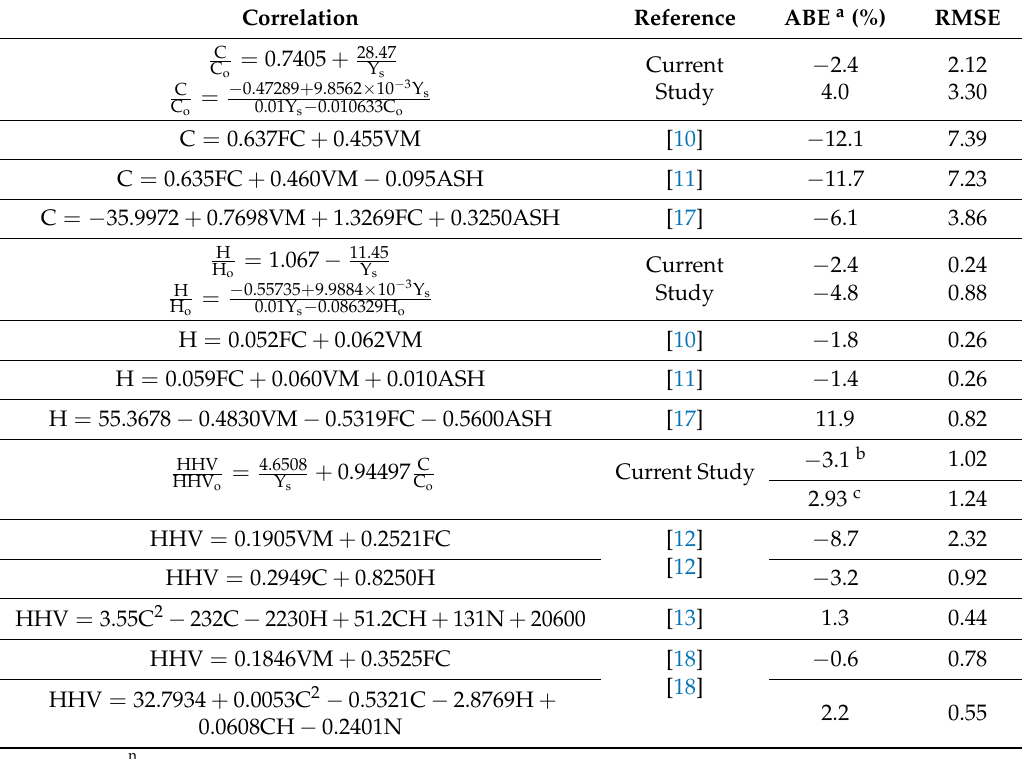
Table 5. Comparison of the newly developed C, H and HHV correlations with